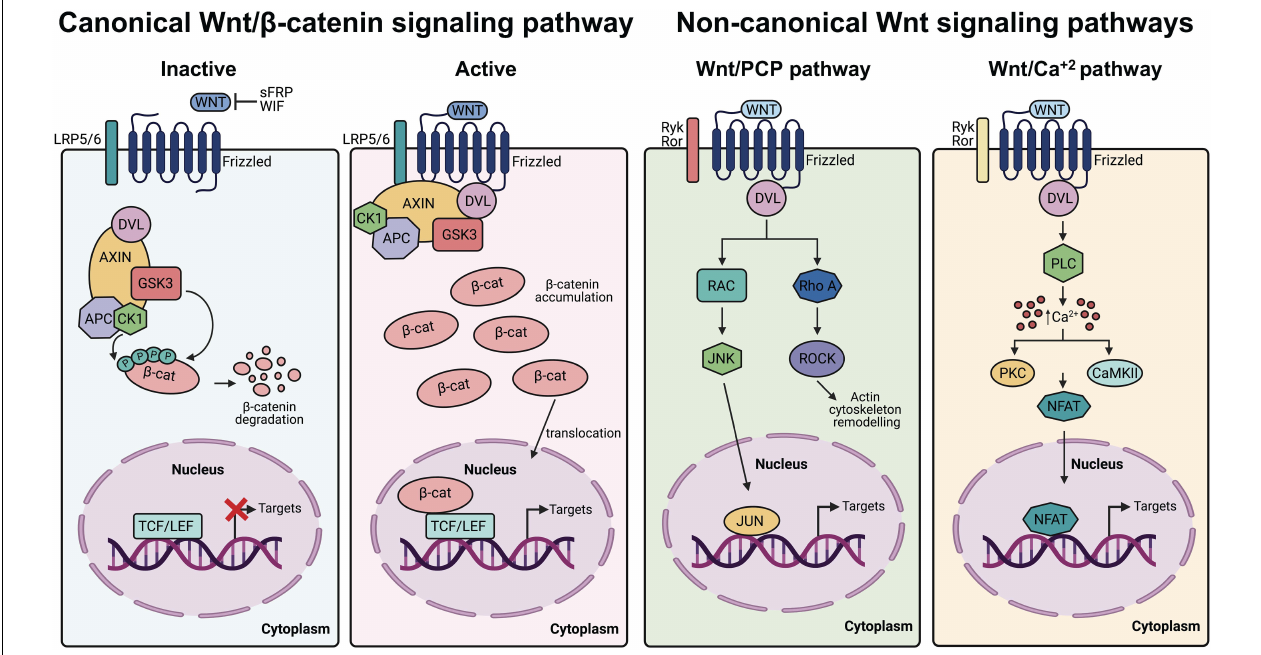
FIGURE 1 | Canonical and non-canonical Wnt signaling pathways. From left to right Canonical Wnt/ β -catenin. In the absence of canonical Wnt ligands (inactive state), the β -catenin destruction complex (AXIN, APC, DVL, CK1, and GSK3) allows the phosphorylation of β -catenin, which promotes its ubiquitination and proteasomal degradation, leading to repressed expression of Wnt/ β -catenin target genes. Conversely, in presence of Wnt ligands (active state), the receptor complex composed of Frizzled and LRP5/6 recruits the destruction complex of β -catenin, which accumulates in the cytoplasm and translocate into the nucleus to promote Wnt/ β -catenin target genes transcription. Non-canonical Wnt pathways. In the Wnt/PCP pathway, non-canonical Wnt ligands bind Ryk/Ror-Frizzled receptors and recruit Dvl leading to the activation of RhoA/ROCK and RAC/JNK. In the Wnt/Ca 2 + pathway, the interaction of non-canonical Wnt ligands with Ryk/Ror-Frizzled increases the concentration of intracellular Ca 2 + and activate downstream kinases and components of the signaling